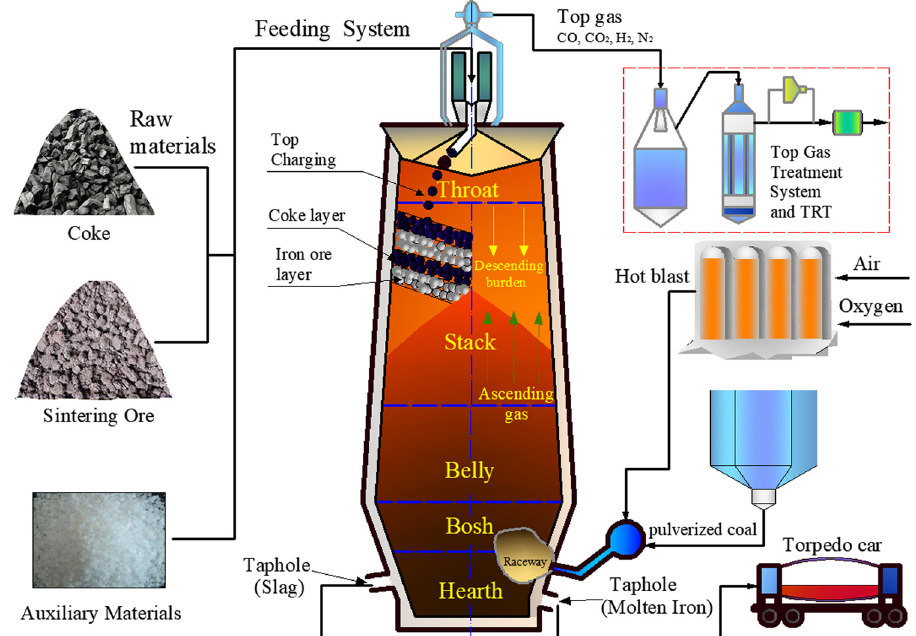
Figure 1: Schematic diagram of